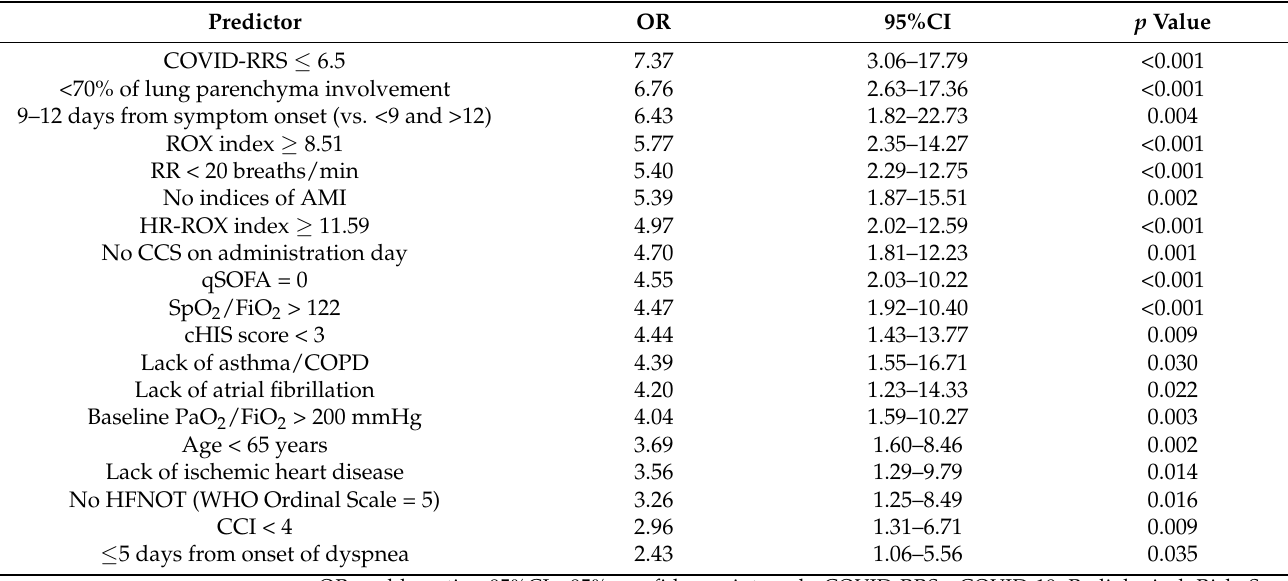
Table 2. Clinical and radiological predictors of clinical response before tocilizumab treatment of severe COVID-19 identified in univariate logistic regression analysis on adjusted